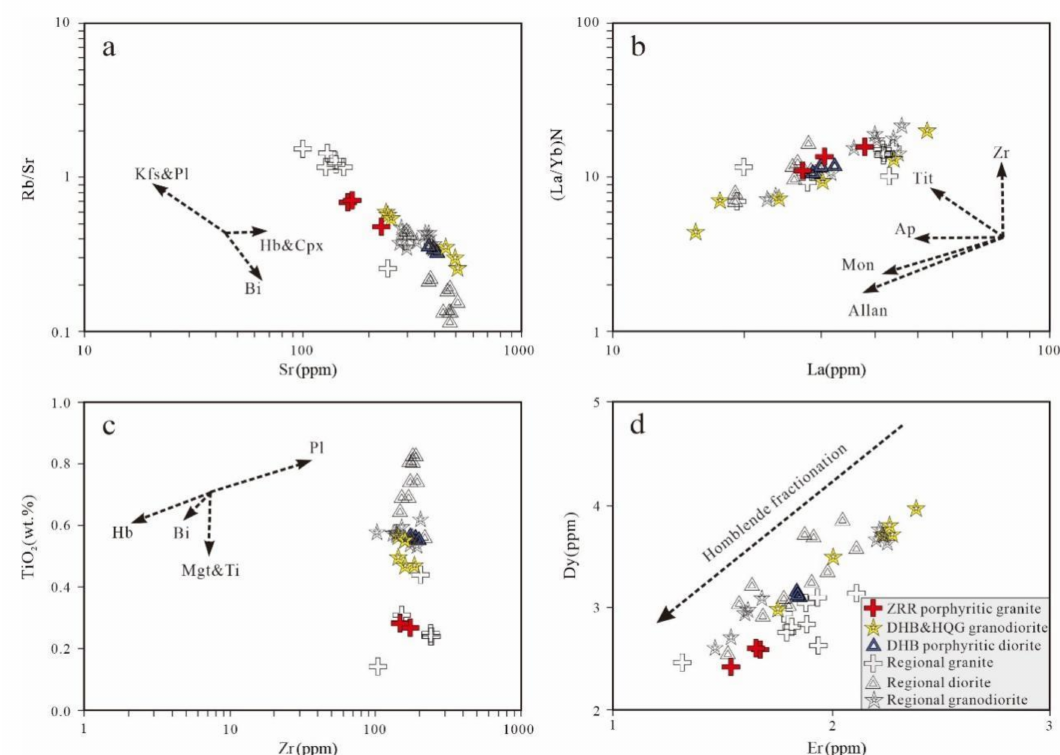
Figure 11. ( a ) Sr–(Rb/Sr), ( b ) La–(La/Yb) N , ( c ) Zr–TiO 2 , and ( d ) Er-Dy plots for intermediate- felsic igneous rocks in the Ela Mountain area. Kfs = K-feldspar; Pl = plagioclase; Hb = horn- blende; Cpx = clinopyroxene; Bi = biotite; Zr = Zircon; Tit = titanite; Ap = apatite; Mon = monazite; Allan = allanite; Mgt = magnetite. The sources of published data are the same as those in Figure